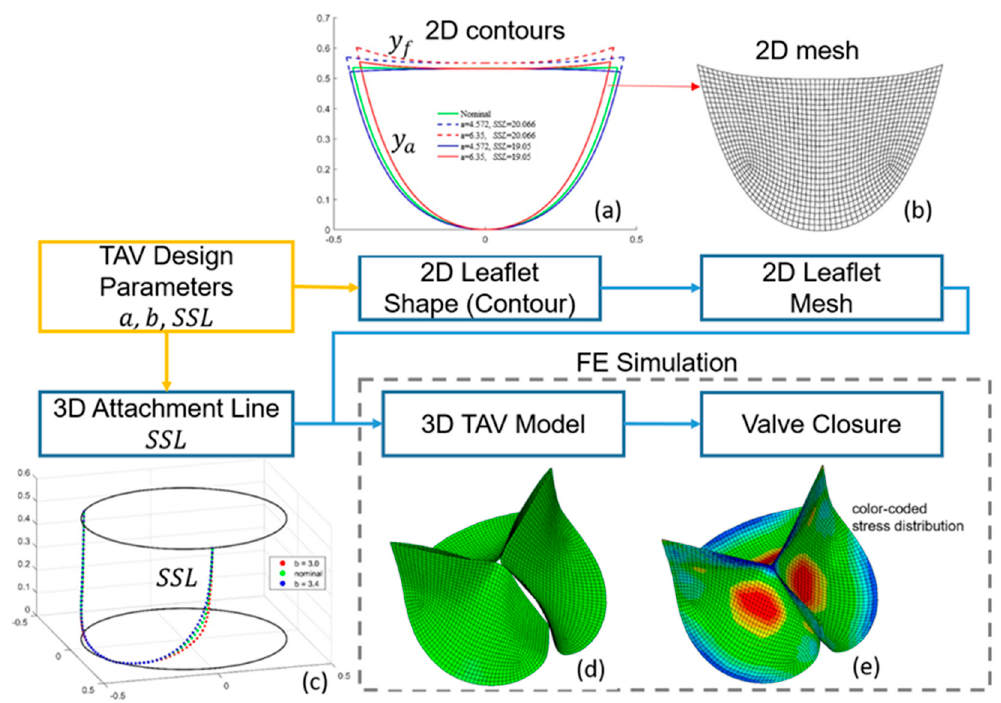
Figure 2. The process of current FEA-based analysis for TAV design. 2D: two-dimensional; 3D: three-dimensional. Examples of 2D designs are shown in ( a ). Each 2D design is converted to a 2D mesh shown in ( b ). The SSL designs are shown in ( c ). The assembled 3D leaflets are shown in ( d ). The valve closure simulation result is shown in ( e ).